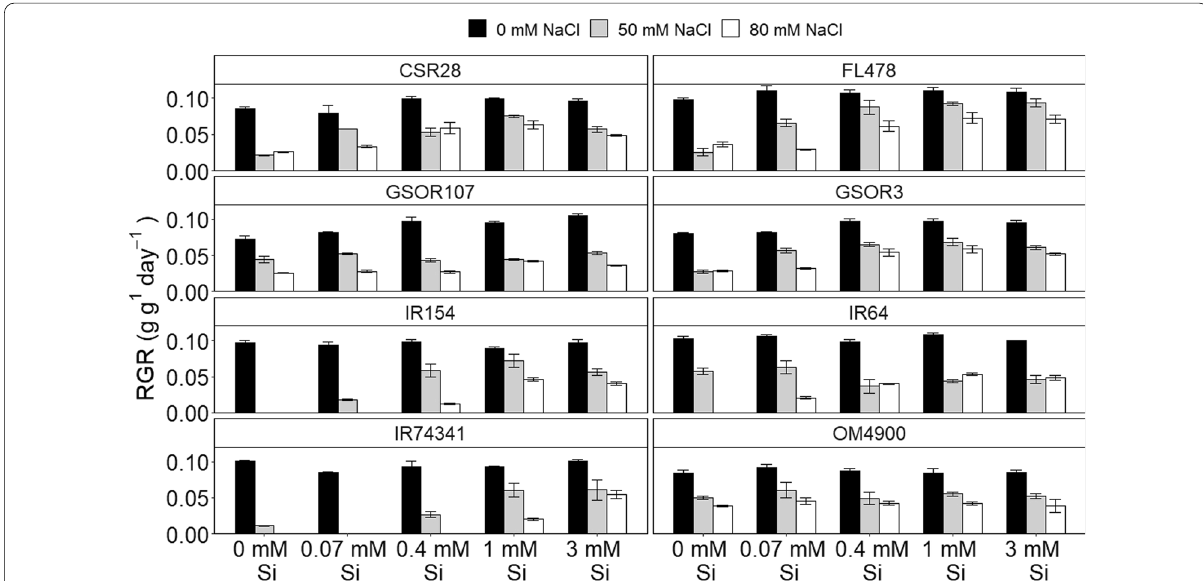
Fig. 3 Growth response of 8 different rice cultivars to salinity and Si. Plants were grown in hydroponics for 30 d at 0, 0.07, 0.4, 1 and 3 mM added Si and with 0, 50 or 80 mM NaCl. Note the total absence of growth in salt sensitive varieties such as IR154 and IR74341 when the medium contains salt and low Si. Also evident is the lack of response to Si in varieties such as OM4900 and GSOR115. Data show means (N